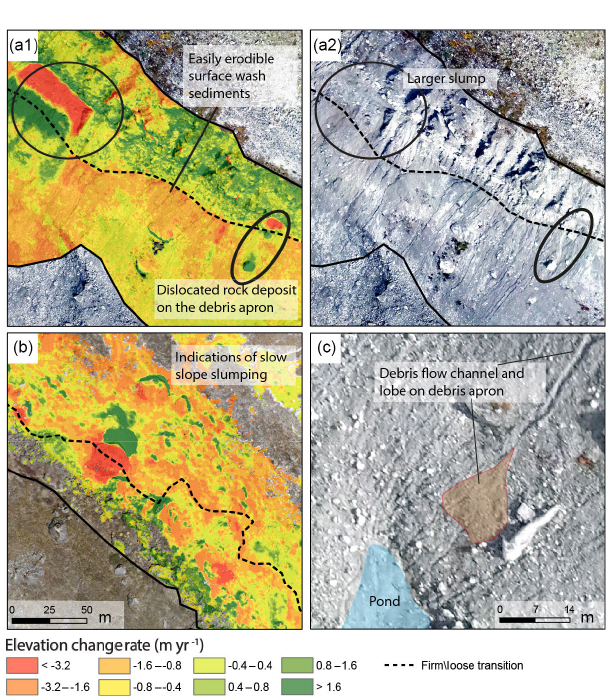
Figure 6. Different types or mass transport processes. Fast mass movements as slumps and rockfall occur on the moraine (a1, a2) as well as water-driven movement as water flow and debris flows (c) . Furthermore, the slopes are slumping down slowly (b) , which is clearly visible by the alternation of positive (rocks moving in) and negative (rocks moving out) elevation change values. See Fig. 2 for